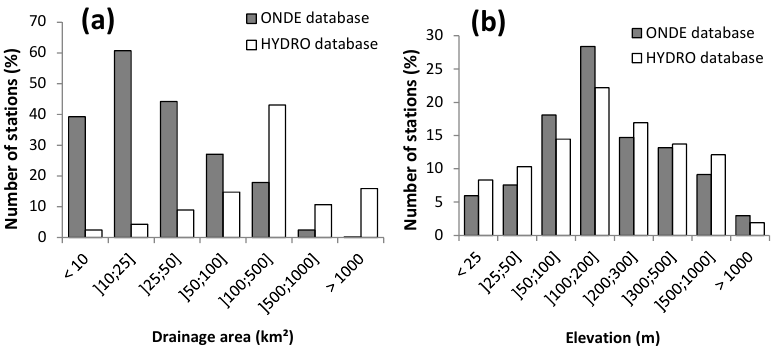
Figure 2. Distribution of the 3300 ONDE sites and of the 1600 gauging stations available in the HYDRO database against (a) drainage area and (b)